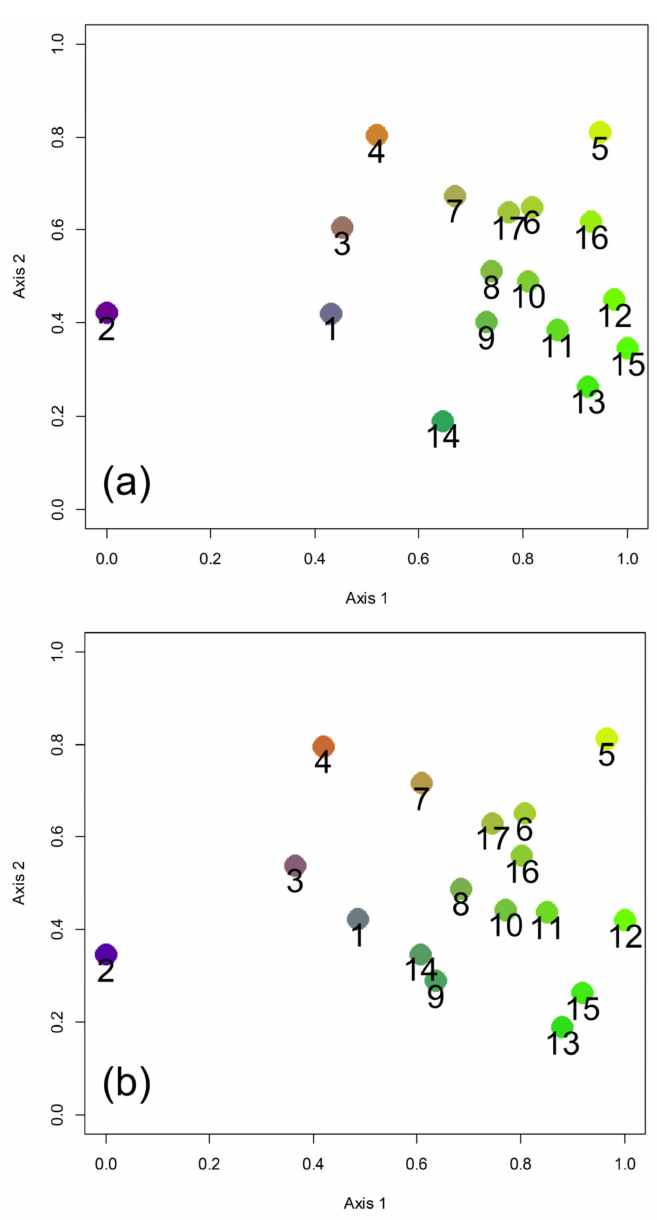
Figure 2. Biogeographical relationships among Italian regions expressed using Non-Metric Multi- dimensional Scaling (NMDS) with the Sørensen index of similarity ( a , stress: 0.107) and Simpson index of similarity ( b , stress: 0.128) based on earwig species composition. Regions are numbered as in Figure